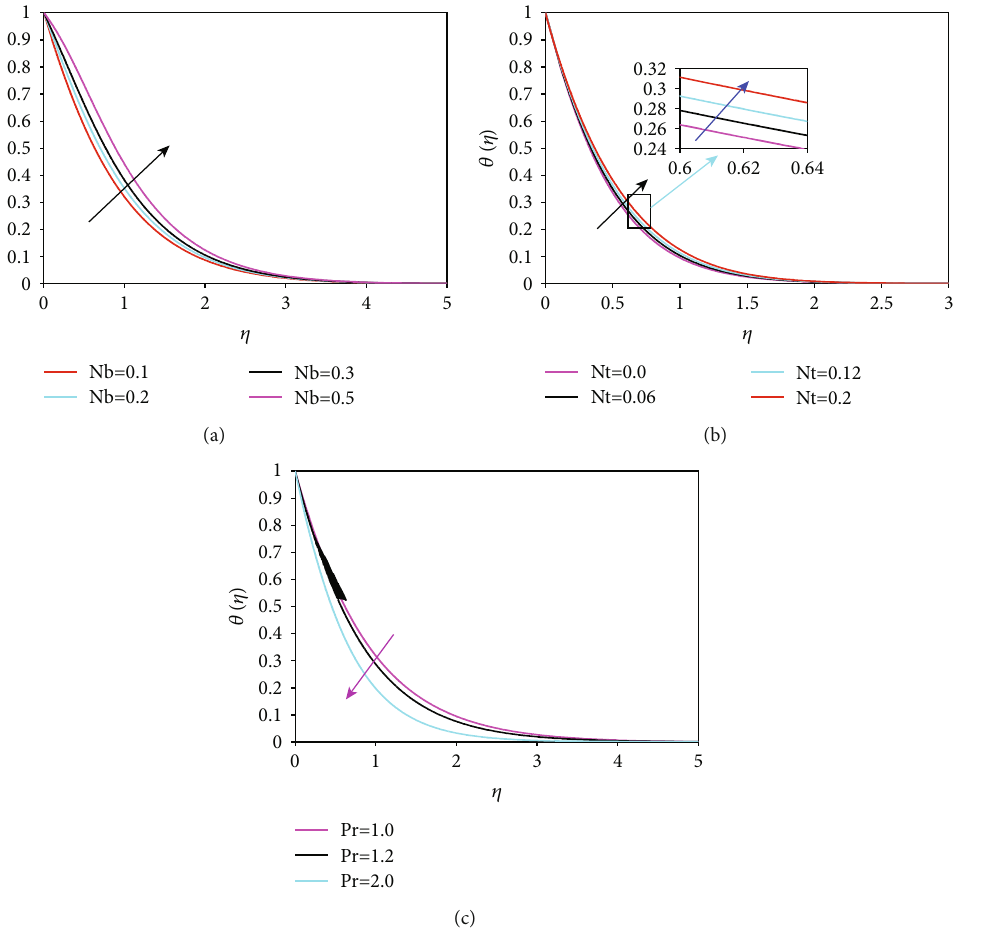
Figure 14: The graph of temperature for di ff erent values of Brownian motion (Nb), thermophoresis parameter (Nt), and Prandtl number (ii) Curvature parameter ( A ) improves velocity pro fi les, but it reduces temperature pro fi les (iii) With an increase of porous parameter ( d ), the pro- fi les of velocity decline whereas temperature and concentration pro fi les are improved